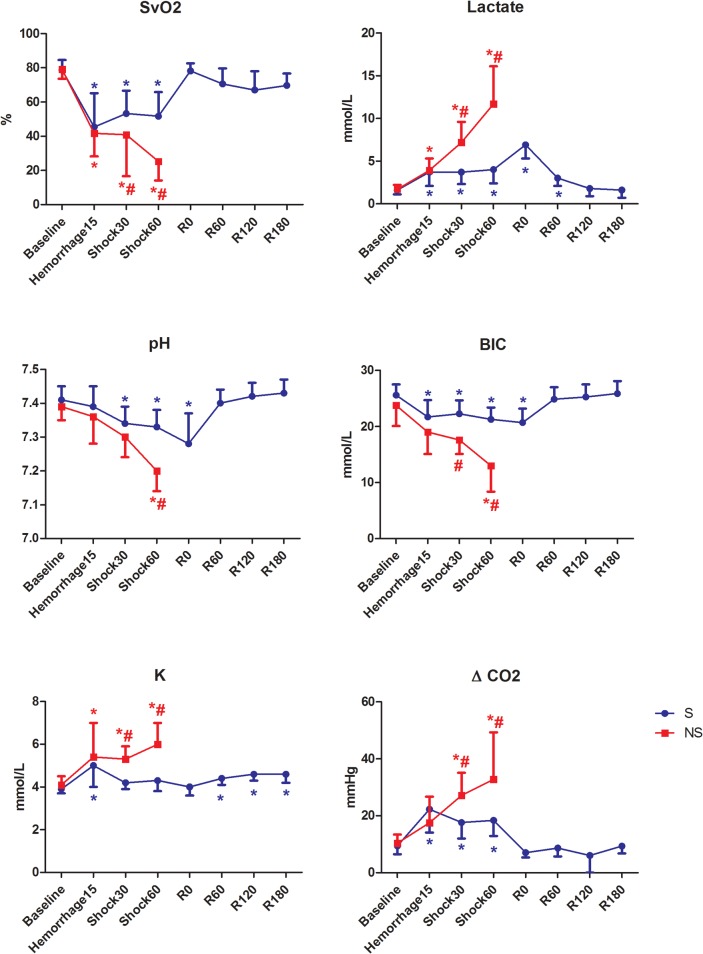
Metabolic variables in pigs submitted to acute hemorrhagic shock and fluid resuscitation.S = survivor group. NS = non-survivor group; * = P<0.05 different from baseline; # = p<0.05 NS group different from the S group (t test).